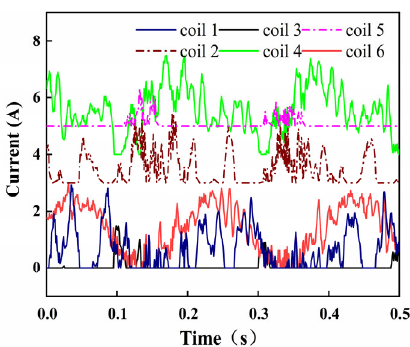
Figure 11. Control current.